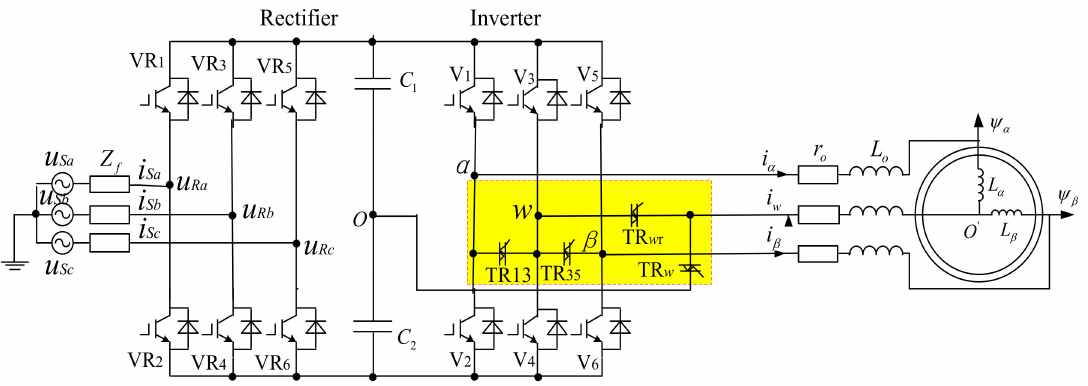
Figure 1. The structure of the electromagnetic stirring power